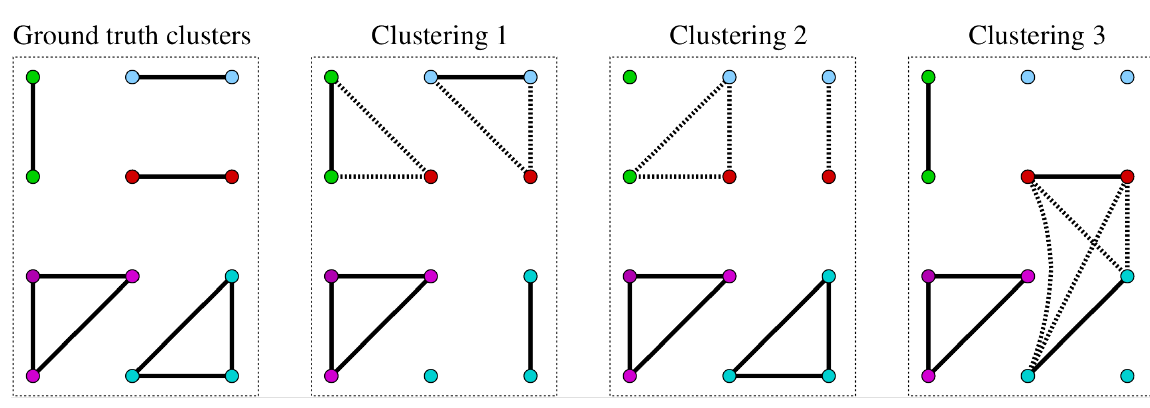
Figure 1: Examples of different cluster predictions. Node colours represent the five true clusters, solid edges true matches (i.e. correctly predicted links), and dotted edges show wrong matches (incorrectly predicted